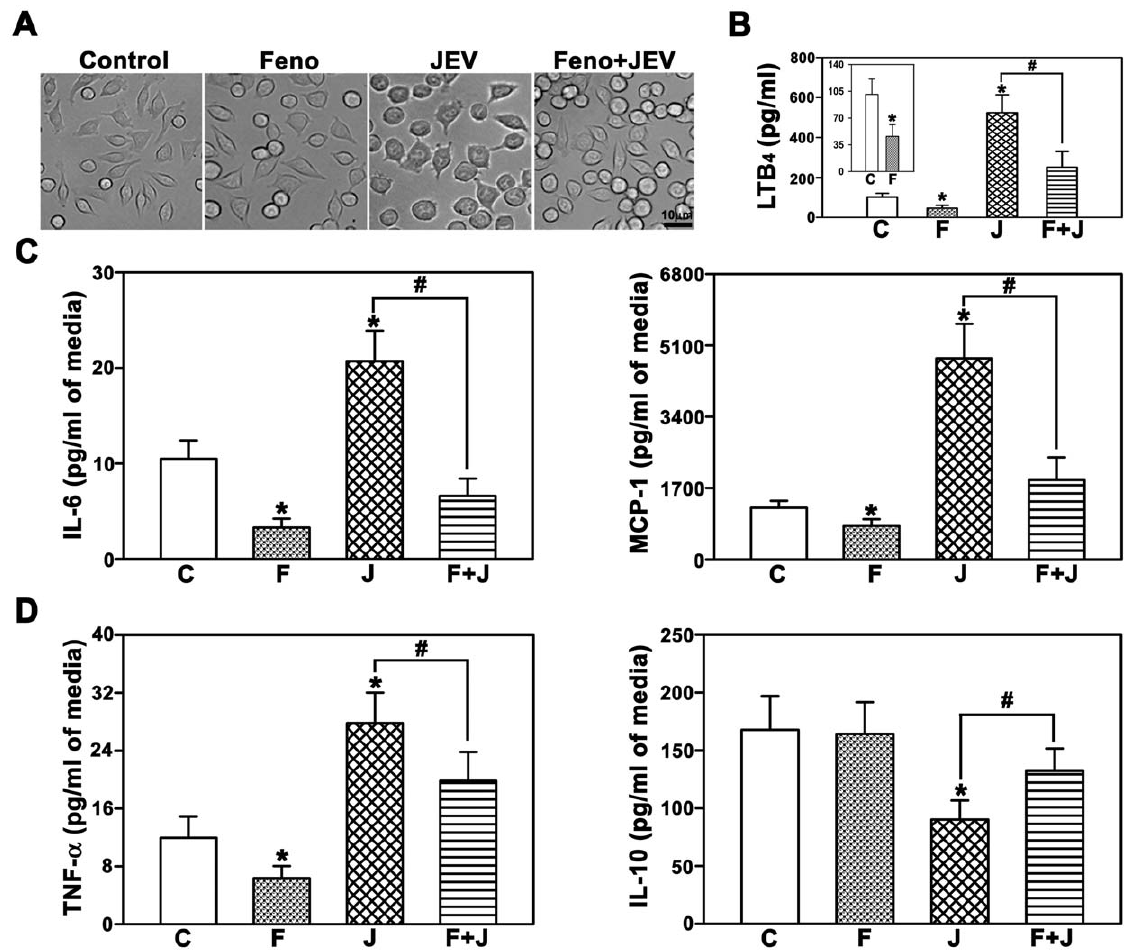
Figure 1. Inflammatory response to Japanese encephalitis virus (JEV), in vitro, is abrogated by fenofibrate. BV-2 cells were treated with vehicle (C), fenofibrate (Feno, F), JEV (J) or both fenofibrate and JEV (Feno + JEV, F + J). (A) Fenofibrate attenuates the morphological changes induced by JEV in BV-2 cells as seen in the phase contrast images. Treatment of BV-2 cells with fenofibrate markedly reduced the levels of LTB 4 (B), IL-6, MCP-1 and TNF- a (C,D) released into the medium after JEV infection. Conversely, protective cytokine IL-10 production was increased in fenofibrate (D) pretreated cells compared to JEV alone (n=6 per group, *and # p , 0.05). Fenofibrate alone results in decreased levels of LTB 4 (inset in B) and cytokines and chemokine